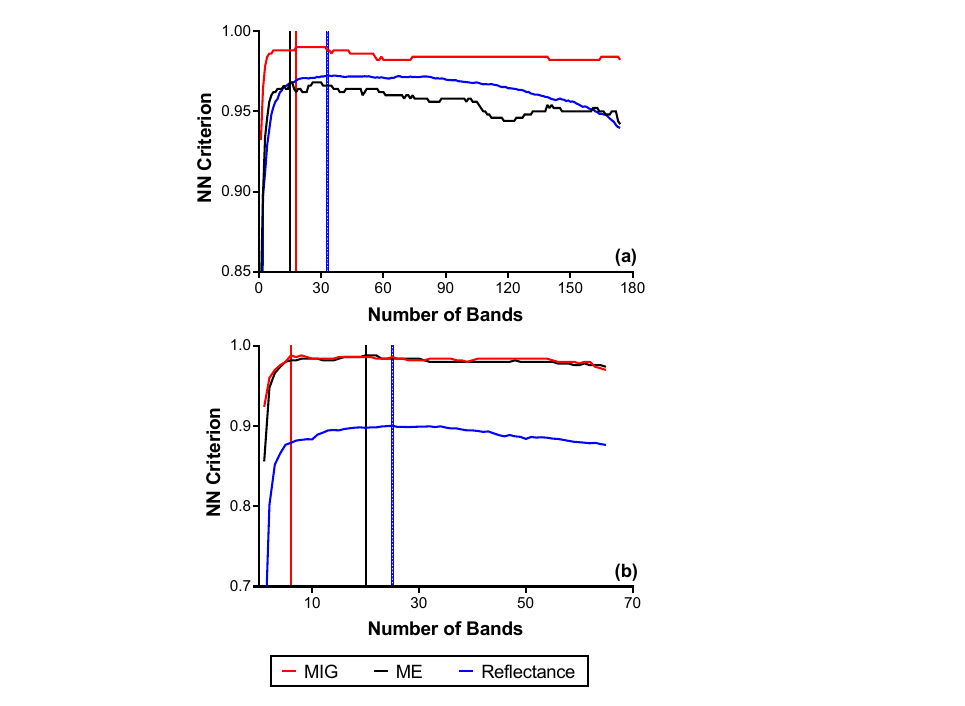
Figure 9. SCM of mangrove and terrestrial forest with vertical lines showing the positions of the optimal bands selected by the forward feature selection (FFS). ( a ) Eighteen bands selected from the MIG–VNIR (250 m), ( b ) 6 bands selected from the MIG–SWIR (250 m) data. Because separability was higher for MIG, positions of optimal ME bands not shown.